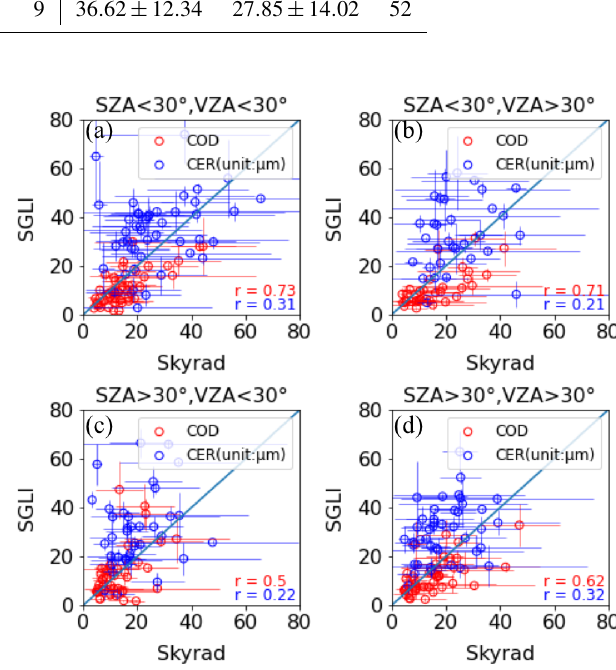
Figure 7. Comparison between the sky radiometer-observed and SGLI-observed water cloud properties for each SZA and VZA value greater than and less than 30 ◦ . The SZA and VZA values corre- spond to the central pixel of the 5 × 5 SGLI pixels.